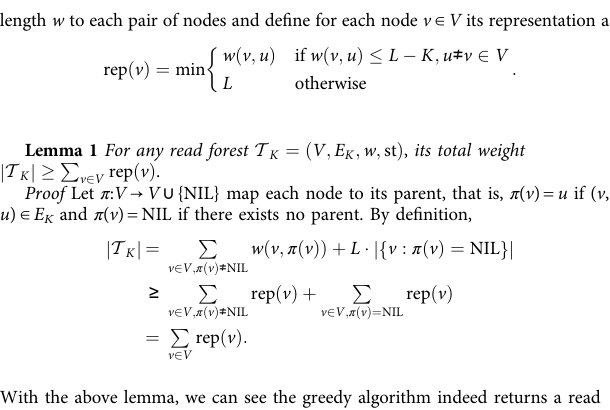
Fig. 4 Cycle-rooted trie. An example cycle-rooted trie constructed from a collection of reads of length 5, with a cycle (in the center) constituting the root